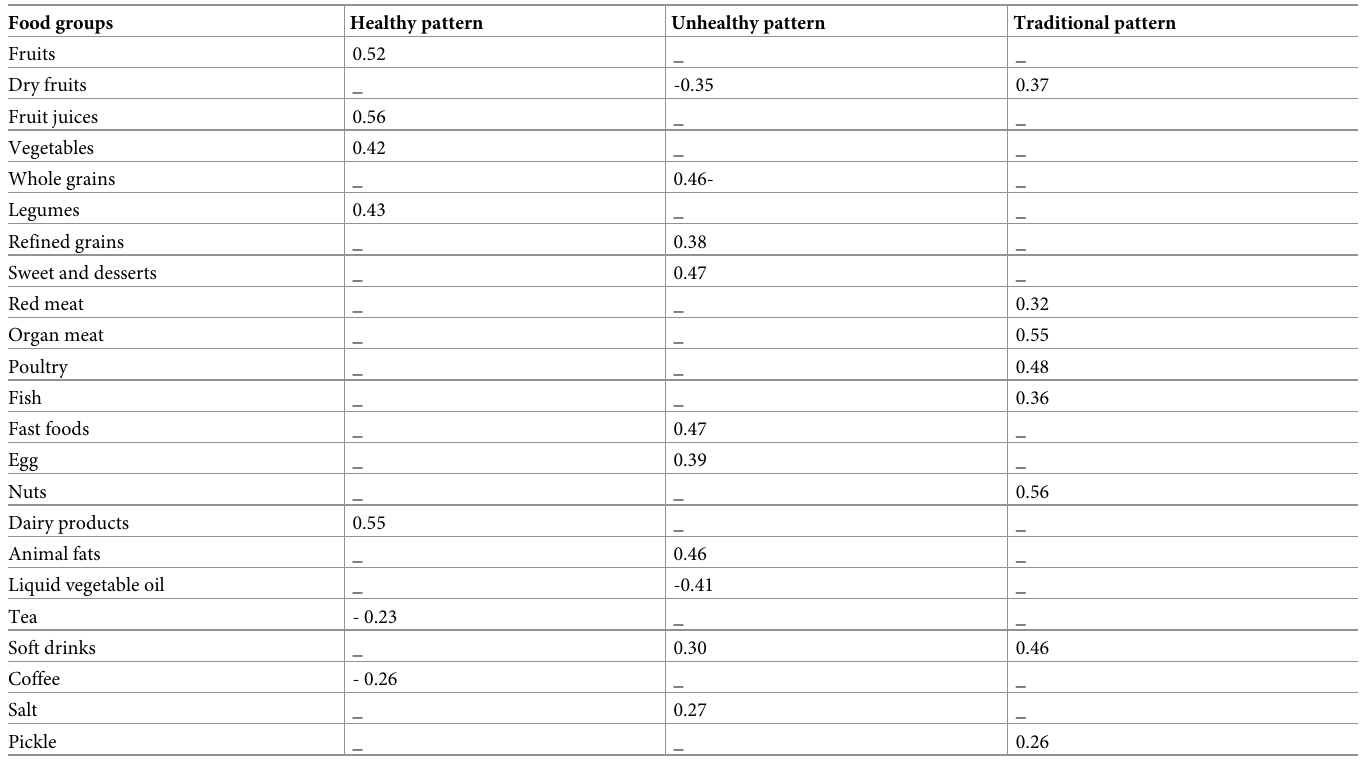
Table 2. Factor-loading matrix for extracted major dietary